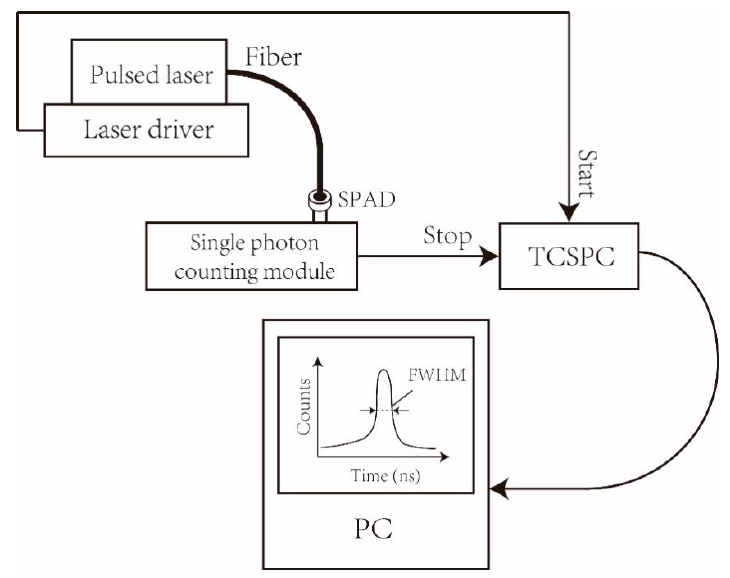
Figure 11. Experimental setup for measuring timing response of the module.